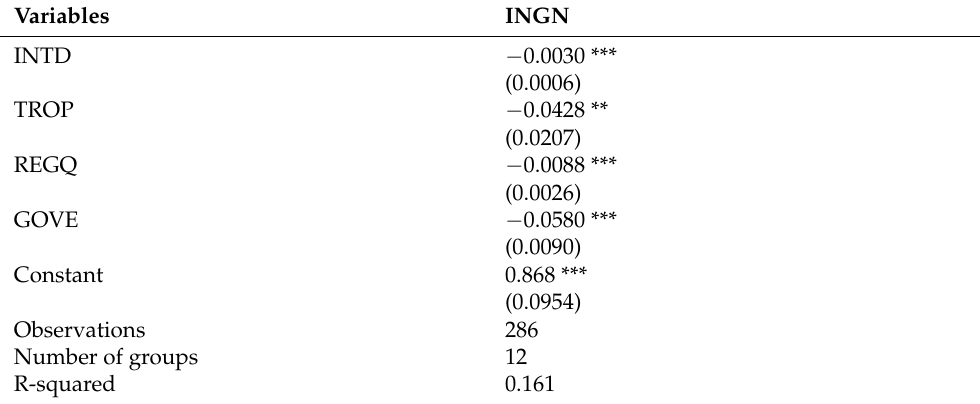
Table 15. Model 5 DV: Income Inequality Gini